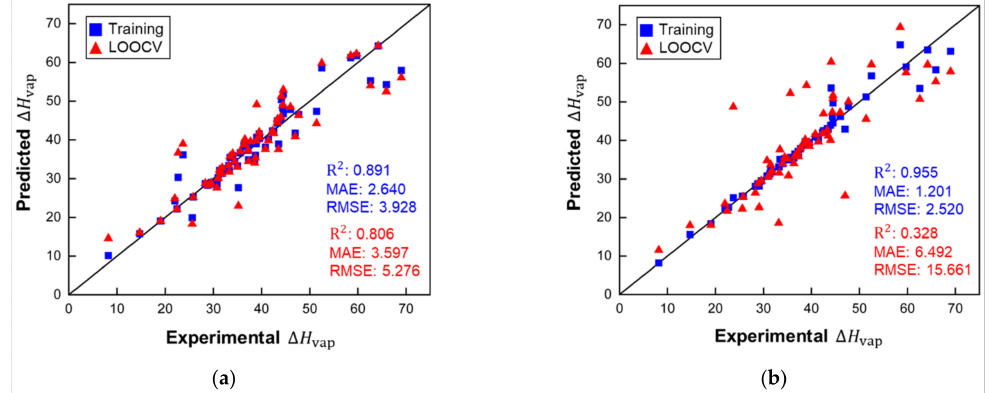
Figure 5. Performance of the KRR models for ∆ H vap predictions of small molecules: ( a ) d = 1 (ARE for the training set: 0.072 and for LOOCV: 0.106), ( b ) d = 2 (ARE for the training set: 0.026 and for LOOCV: 0.184). ∆ H vap , MAE and RMSE in